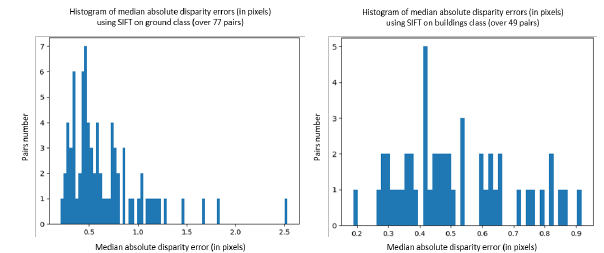
Figure 6. Histograms of median absolute disparity errors (in pixels), computed using SIFT matches, on ground class on the left (77 pairs), and on buildings class on the right (49 pairs). Same pairs as in Tab.